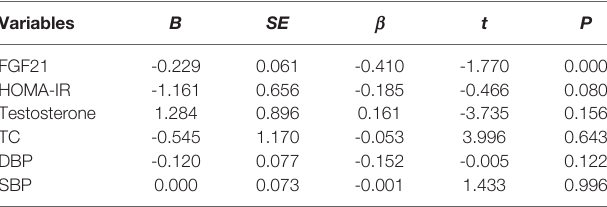
TABLE 3 | Multivariate linear regression analysis on the in fl uencing factors of IIEF-5 score in human study. Variables B SE b t P